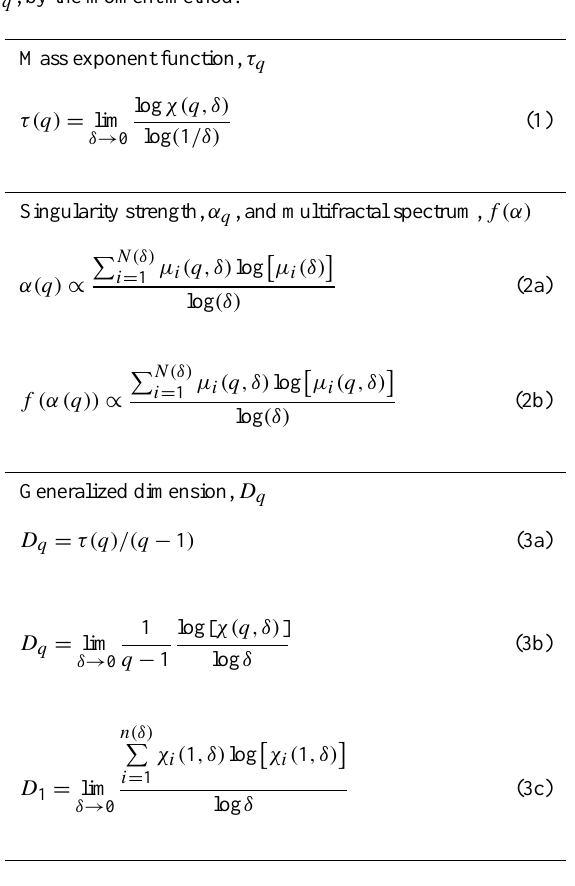
Table 2. Algorithms used for computing mass exponent function, τ q , singularity spectrum f (α) versus α q and generalized dimension, D q , by the moment